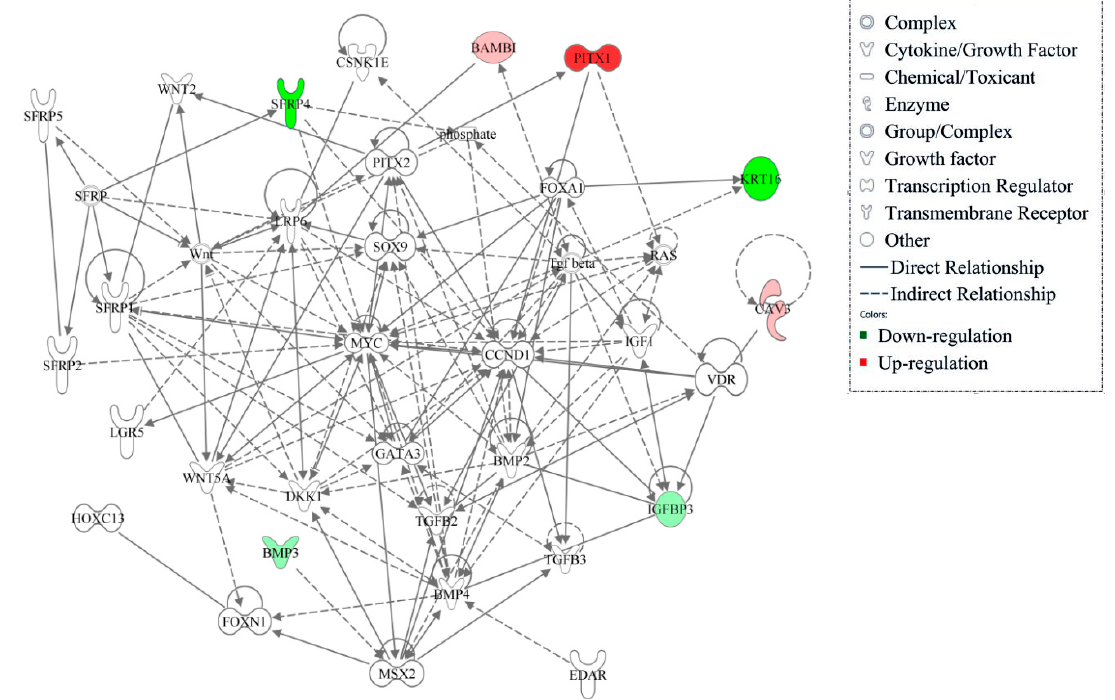
Figure 7. Interaction of potential genes related to wool follicles development. Color indicates the expression of the gene in DR135 vs. D135. Red represents up-regulation of gene expression and green represents down-regulation of gene expression ( | log2 (fold change) | > 0.5). The intensity of green and red molecule colors indicates the degree of down or up-regulation, respectively. White molecules are not differential expression (|log2 (fold change)| < 0.5).